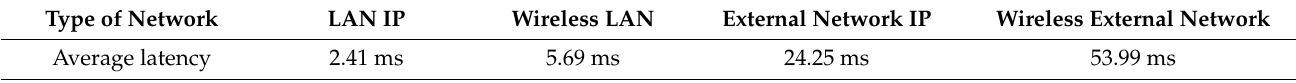
Table 2. Data latency evaluation of the proposed fog platform.